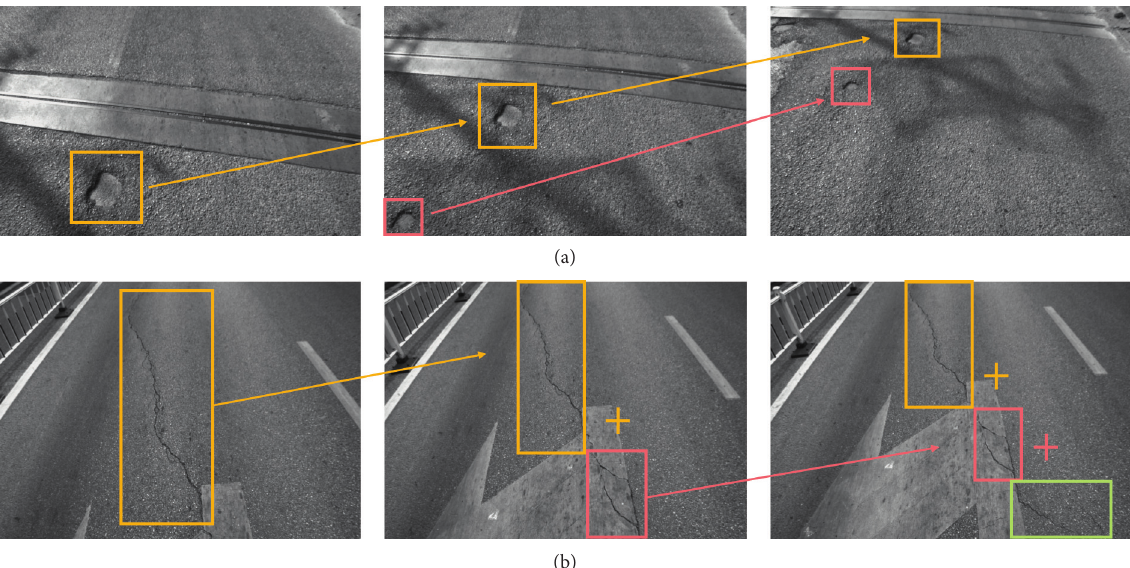
Figure 1: Typical problems of pavement distress images. (a) The same pothole with different sizes and locations in different pictures. (b) A longitudinal crack crossing three